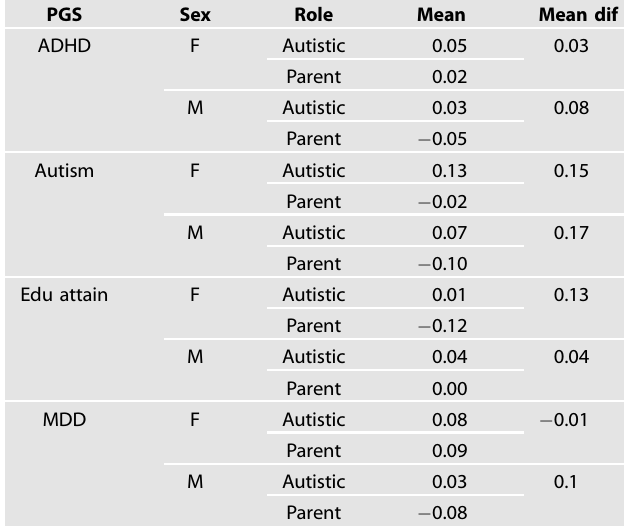
Table 3. Difference in grouped mean PGS between the autistic individuals and their sex-matched